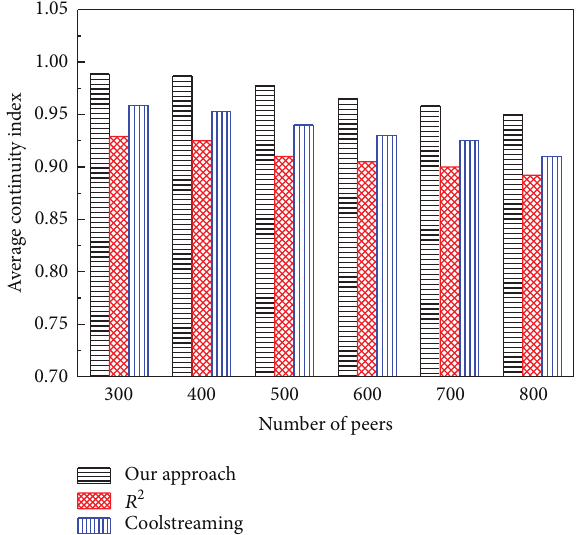
Figure 8: Average continuity index versus peer number.